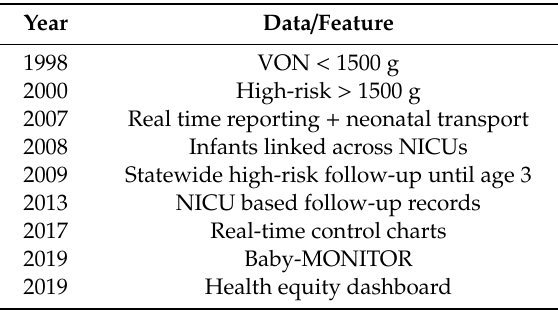
Figure 2. Data to support perinatal quality improvement in California from the CPQCC and California Maternal Quality Care Collaborative (CMQCC) data centers. Images in this figure are licensed for use from iStock.com. NICU: neonatal intensive care unit; VLBW: very low birth weight. Table 1. CPQCC Database Development. Table 1. CPQCC Database Development.